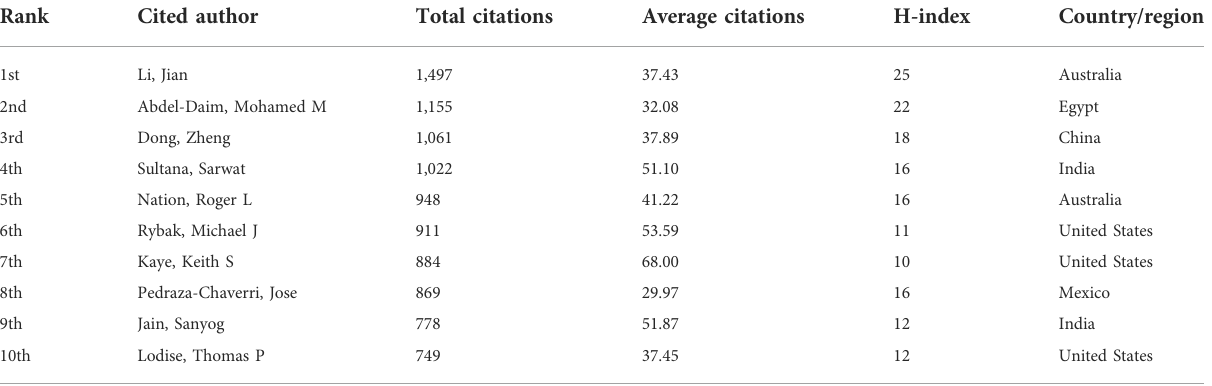
TABLE 2 Top 10 authors distributed by citations in nephrotoxicity research.